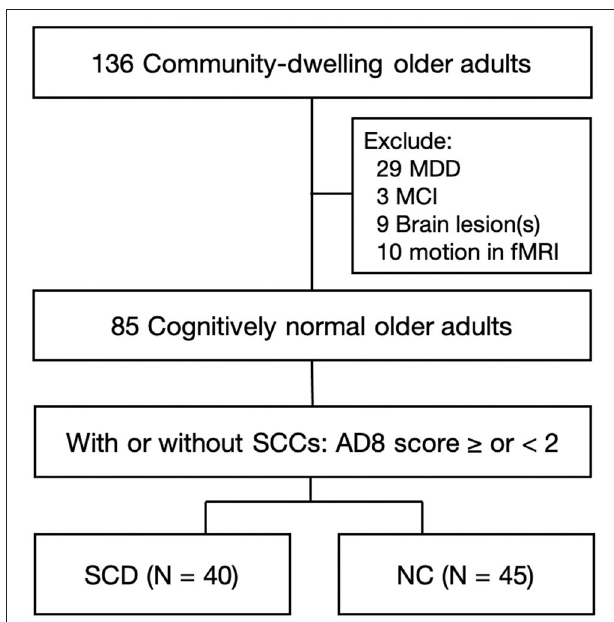
FIGURE 1 | Flow chart of enrollment. Healthy older adults aged over 50 years were enrolled from the communities. Initial screening excluded the participants who had a current state or previous history of MDD, met the criteria of MCI, had brain lesions in structural MRI, or had head motion during fMRI scans. These 85 cognitively normal older adults were further divided into the group of SCD and NC, based on having or not having SCCs by an AD8 score ≥ 2 or < 2 points. MDD, major depressive disorder; MCI, mild cognitive impairment; SCCs, subjective cognitive complaints; SCD, subjective cognitive decline; NC, normal control.